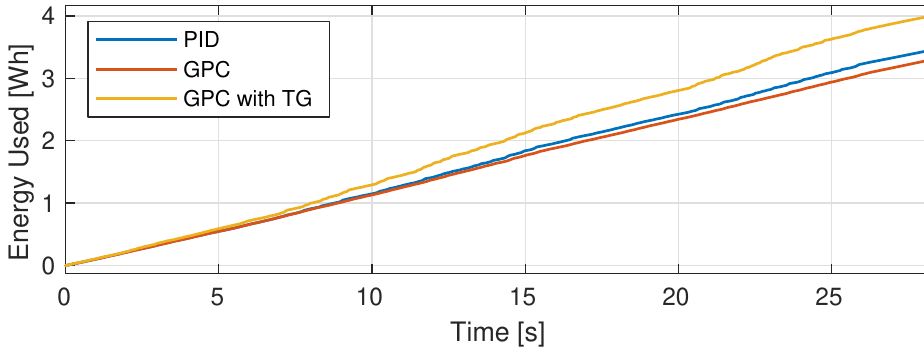
Figure 6. Total energy consumption during the Fixed Trajectory Experiment for all the controllers.